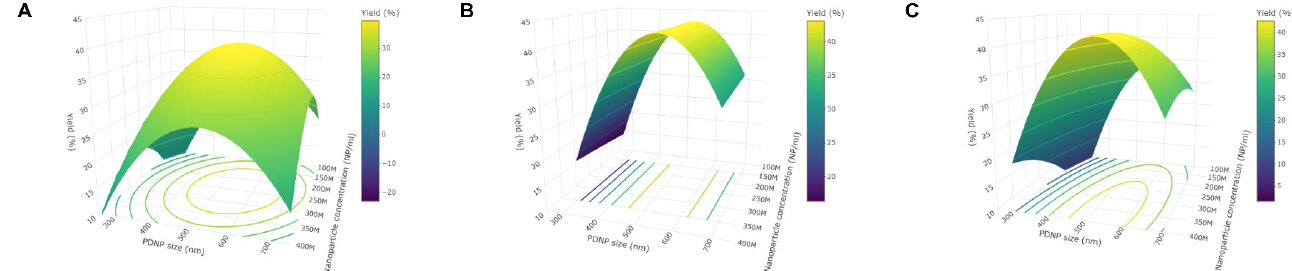
Figure 4. Representative response surfaces where the PDNP size was kept constant, and the other factors were varied. ( A ) CCC design-based model output visualized, showing a clear optimum. ( B ) BBD-based model output visualized, with no clear optimum being present in the investigated design space. ( C ) Revised BBD-based model output visualized, now showing a clear optimum.